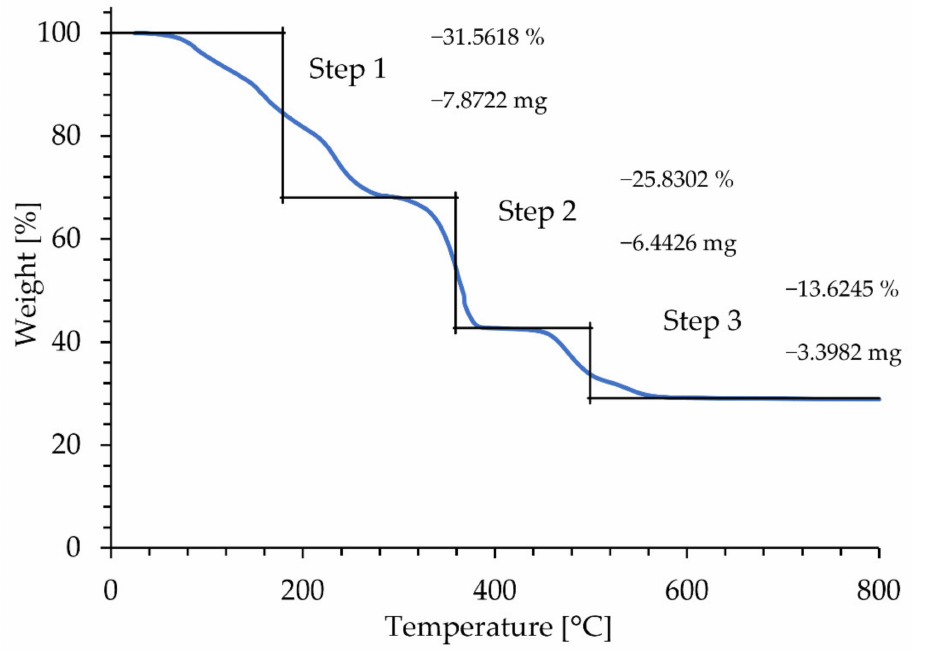
Figure 3. TGA plot of the thermal decomposition of Y(NO 3 ) 3 × 6 H 2